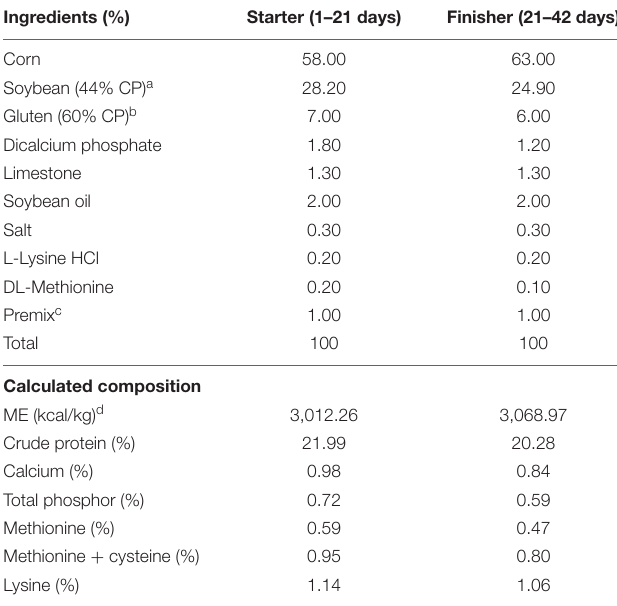
TABLE 1 | Ingredients and nutrients composition of the basal diets (DM basis). Ingredients